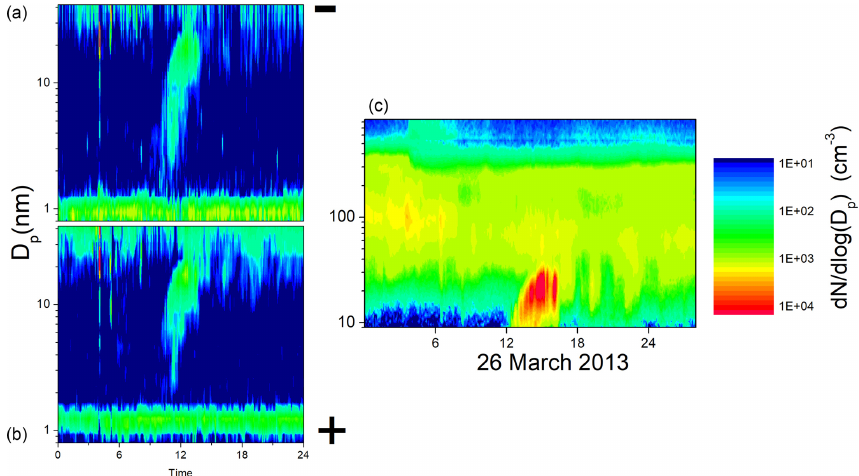
Figure 9. Nucleation event observed at Finokalia on 26 March 2013 as captured by AIS (left panels for negative (a) and positive (b) polarity) and SMPS (c) (time in UTC+2).